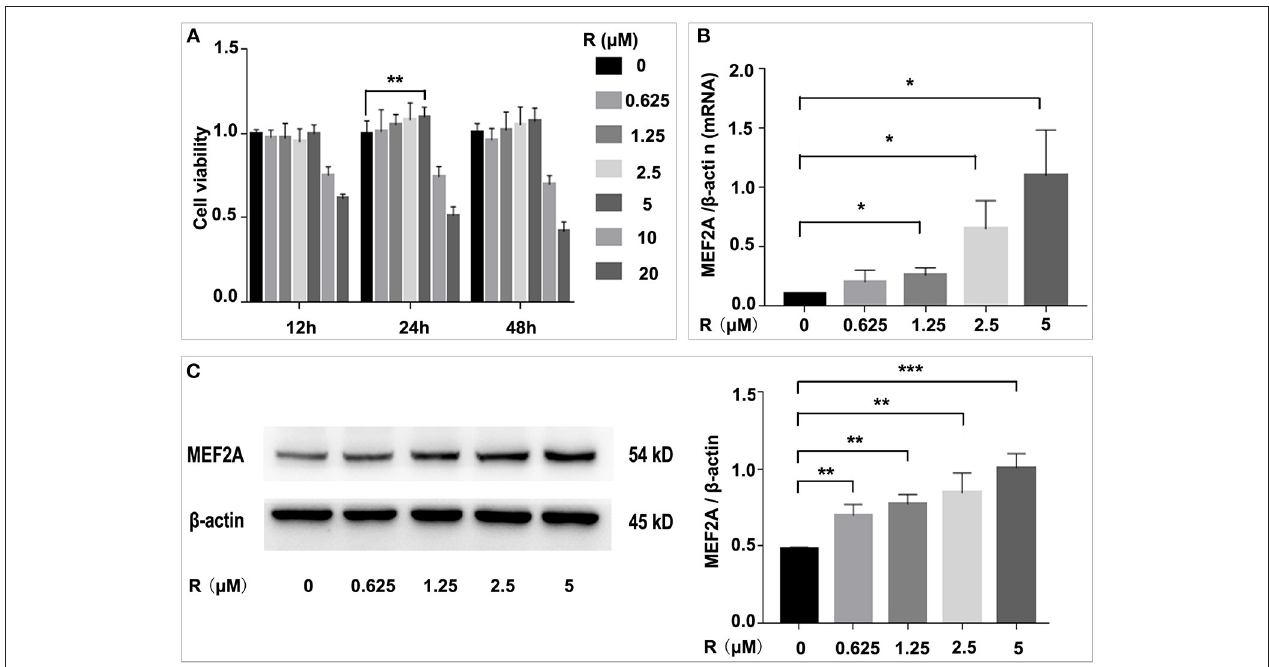
FIGURE 1 | Influence of resveratrol on cell viability and the expression of MEF2A. (A) Impact of treatment of HUVEC with gradient concentration of resveratrol for various time on cell viability. (B) The mRNA level of MEF2A in HUVEC treated with gradient concentration of resveratrol for 24h. β -actin was used as the internal control to normalize the MEF2A mRNA level. (C) Immunoblots of MEF2A. β -actin was used as a loading control. Quantification of band intensity was performed via image-J and values were normalized to beta-actin. All experiments were performed independently for three times. Mean ± standard deviation (SD) is showed as bar plot. The statistical significance is analyzed by the unpaired Student’s two-tailed t -test. ns, no significance; * P < 0.05; ** P < 0.01; *** P < 0.001 between groups